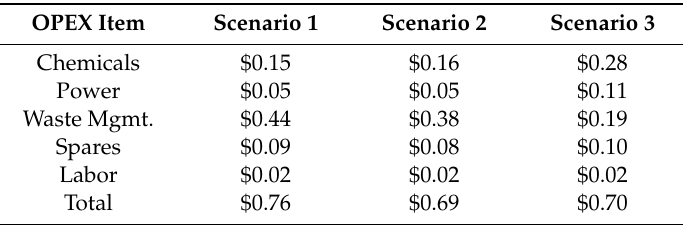
Table 11. OPEX breakdown in $ / m 3 of influent per